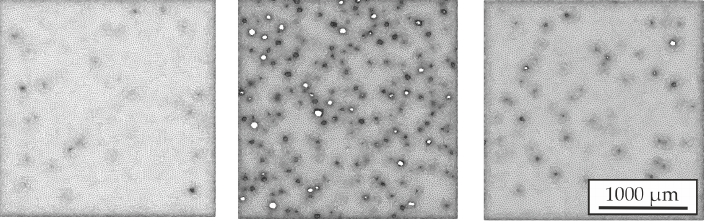
Figure 5. FE meshes reconstructed from µCT data. Contour ( left ), interface ( mid ) and hatching area ( right